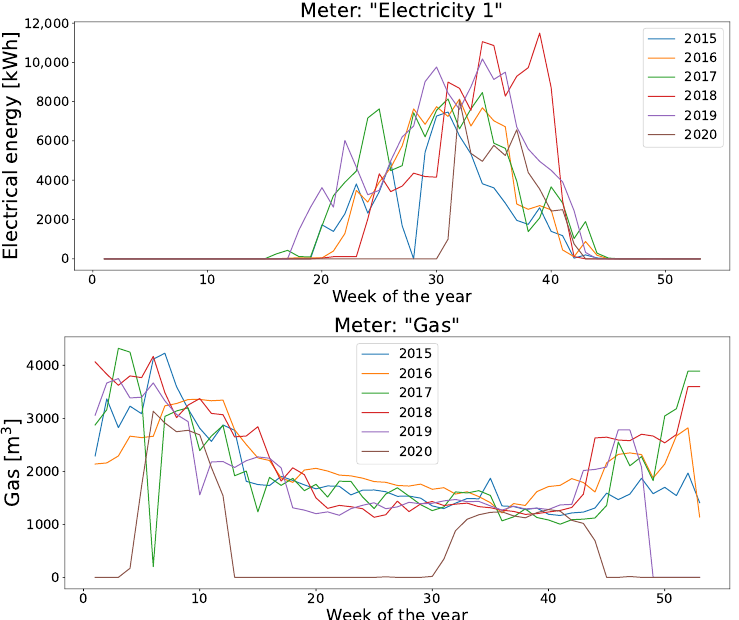
Figure 10. Yearly analysis with weekly sampled readings for meters “Electricity 1” and “Gas”.